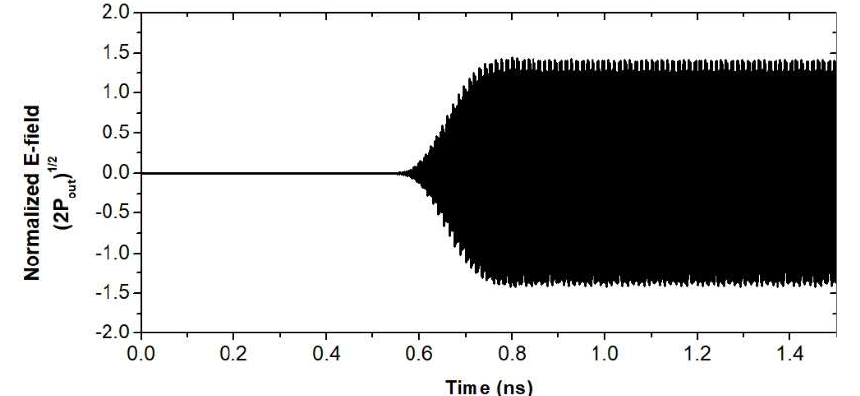
Figure 22. The output signal of the PA-HHTWT at 346 GHz.